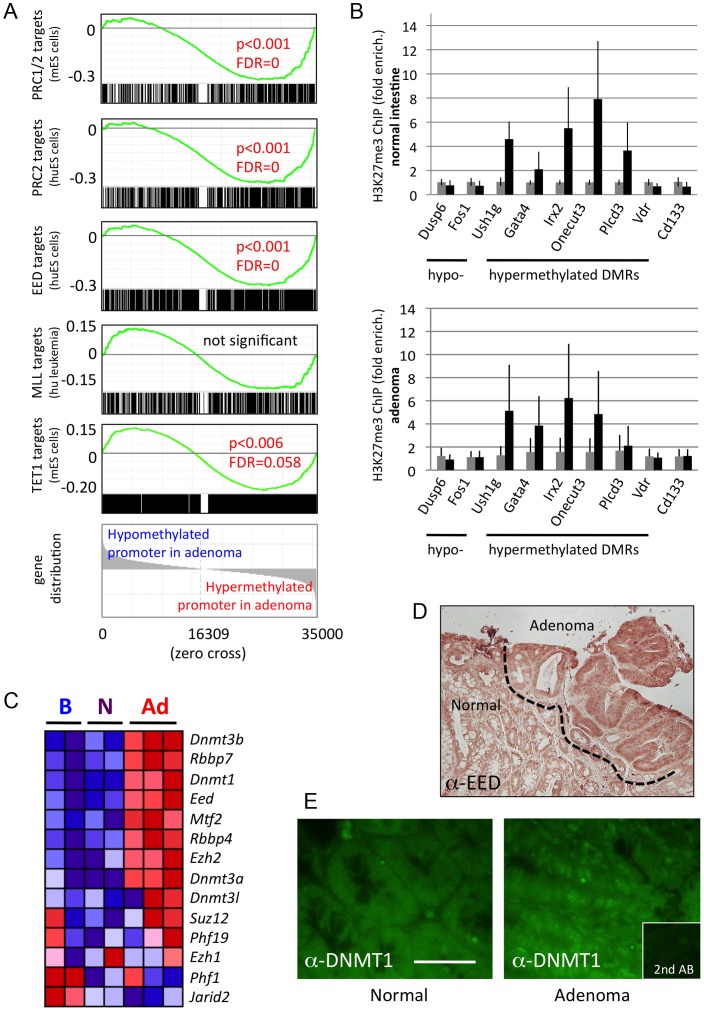
Hypermethylated DMRs are associated with Polycomb targets.a) Gene Set Enrichment Analysis (GSEA) [35] is used to probe established epigenetic signatures. Mouse genes were ordered by normal (6 samples) versus adenoma (5 samples) promoter methylation (−1,0 to +0,5 kb). Gene signatures comprising PRC1/2 target genes or mouse homologues of human targets of PRC2 complexes, EED targets, MLL targets or TET1 targets were mapped onto the ordered list, and enrichment at the extremes (hypo- or hypermethylation) was assessed. PRC and EED targets were found strongly enriched among hypermethylated promoters, while no enrichment was detected for MLL targets. TET1 targets were found weakly enriched among hypermethylated promoters, probably due to their known association with PRC complexes, and prevalence at CpG-rich sites [34]. Enrichment score graphs (top, green), signature gene distributions (black line graphs, below ES curves), p-values and false discovery rates (FDRs) are given. Significance cut-offs were P<0.05, FDR<0.25. b) Analysis of H3K27me3 marks in chromatin of mouse intestinal epithelium (n = 4 biological replicates) and adenoma (n = 3), using chromatin immunoprecipitation, followed by qPCR. black bars: Immunoprecipitated chromatin, grey: Input chromatin. Error bars give standard deviation. c) Expression of genes coding for PRC2 components or DNA methyl transferases, as determined by RNA-seq. Gene expression is colour-coded: red, high relative expression; blue, low relative expression. d) Immunohistochemical staining of EED in mouse intestine and adenoma. Dotted line demarcates normal intestinal tissue from adenoma. Adenoma contains higher levels of cytoplasmic and nuclear EED protein. e) Immunofluorescence analysis of DNMT1 in a section of normal intestine and adjacent adenoma of the mouse. Adenoma displays distinct nuclear fluorescence for DNMT1. Scale bar is 50 µm.